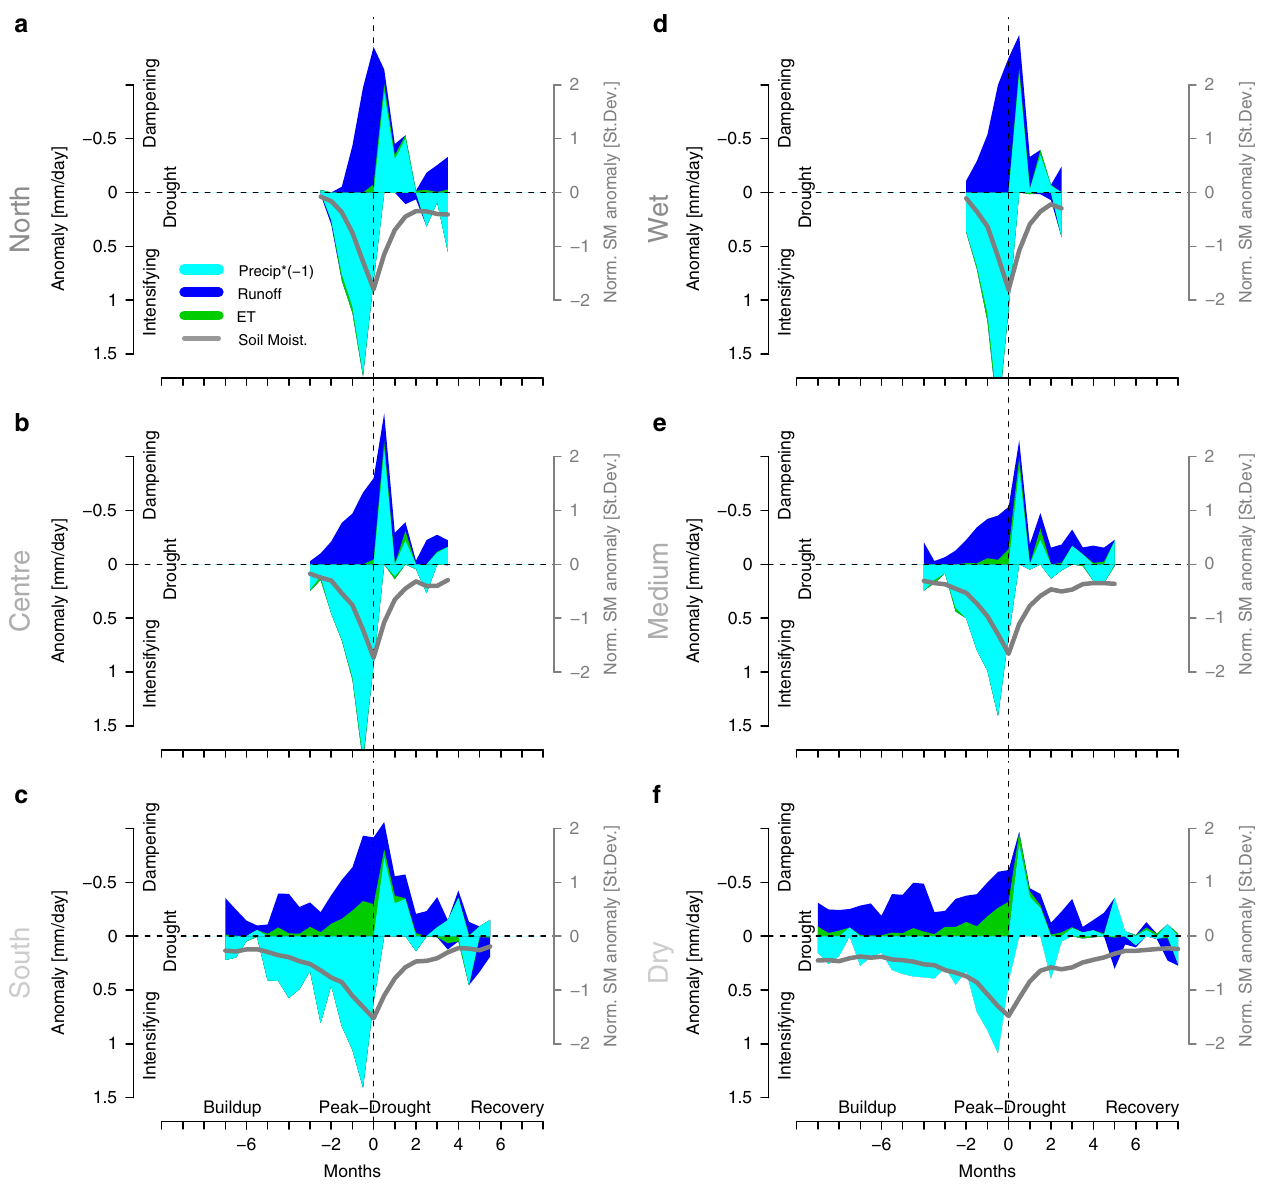
Fig. 2 Evolution of major water balance components during droughts. Time evolution of anomalies in precipitation, runoff, and evapotranspiration (ET) averaged across the ten strongest annual droughts during 1984 – 2007. a – c Mean evolution over all catchments in each region. d – f Mean evolution over catchments grouped into three equally large groups with respect to dryness index. Further, the corresponding mean soil moisture evolution during drought is shown in gray with the y -axis on the